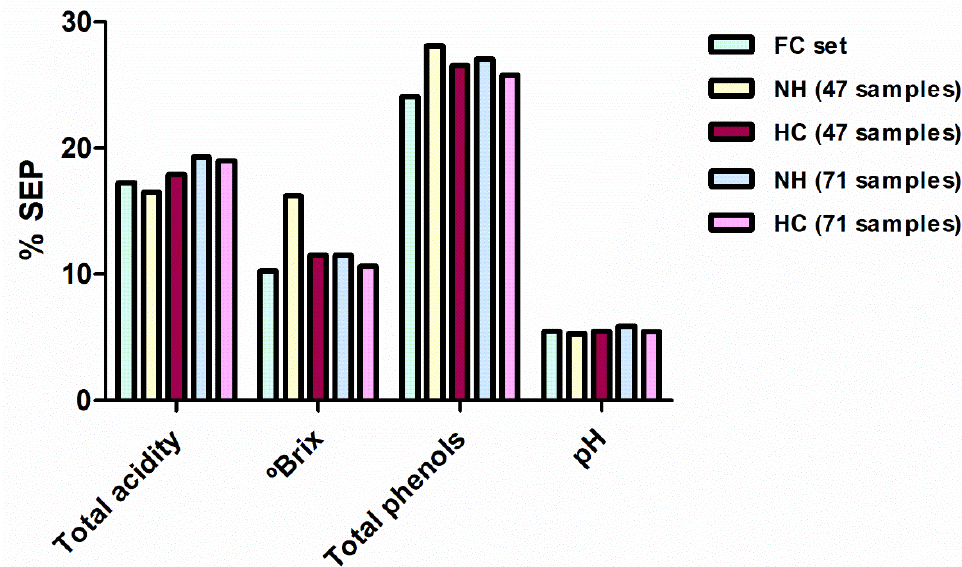
Figure 4. Comparison between the SEP in external validation for the models developed for all the reference parameters for FC, NH-47, HC-47, NH-71 and HC-71 sample sets. SEP are expressed as percentages taking into account the applicability range of their respective models. SEP: standard errors of prediction; NH: Neighbourhood Mahalanobis distance; FC, full calibration; HC: Hierarchical Clustering.